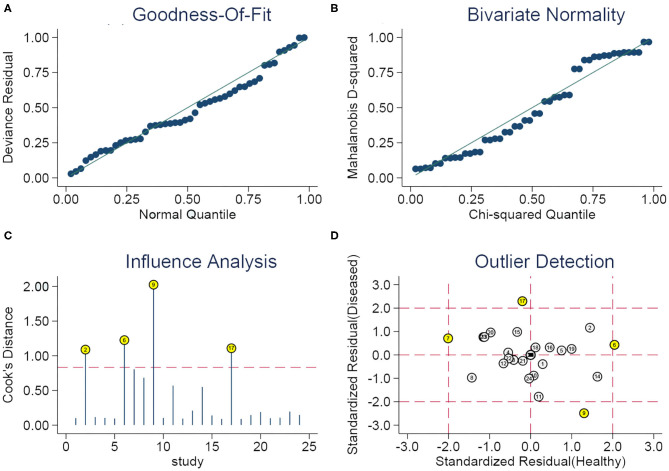
Sensitivity analysis. (A) Goodness of fit, (B) bivariate normality, (C) influence analysis, and (D) outlier detection.